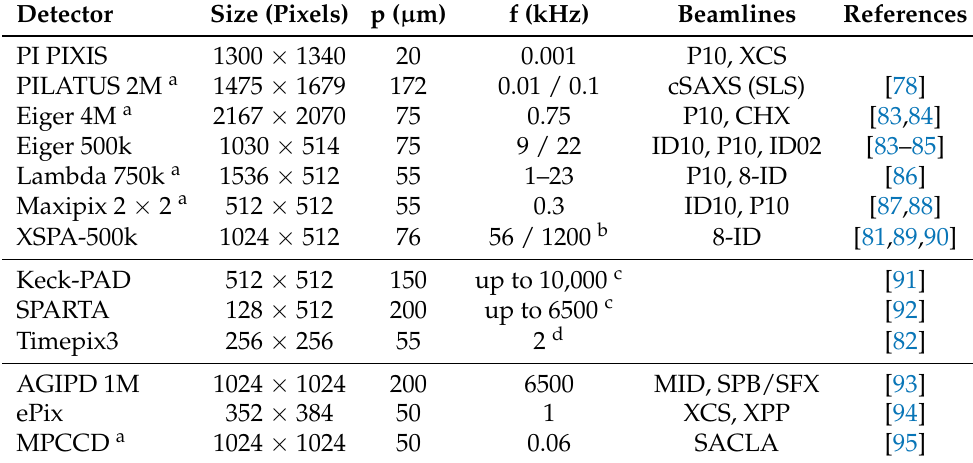
Table 1. Detectors used for XPCS experiments. Here, p is the pixel size in one dimension, and f the maximum frame rate. Note that different versions may exist, e.g., the data for the dual MPCCD and a single module of ePix are given. Different frame rates are connected to different operation modes or detector versions. Notes: a Different versions with various sizes and frame rates available. b Continuous and burst-mode operation. c In burst modes with different number of